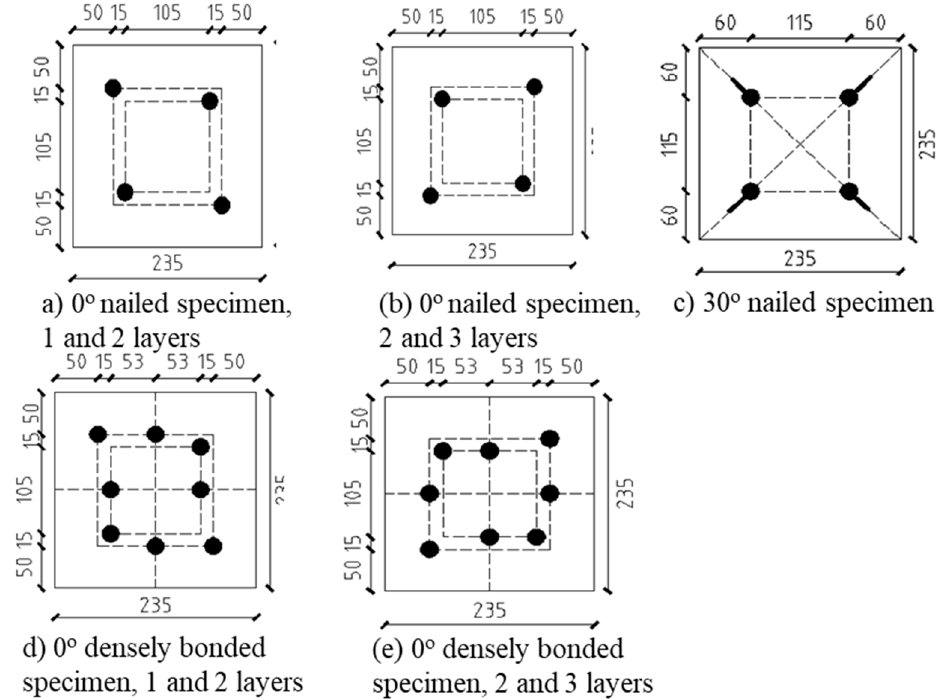
Figure 2. Partial detail of top view of each group of test specimens.